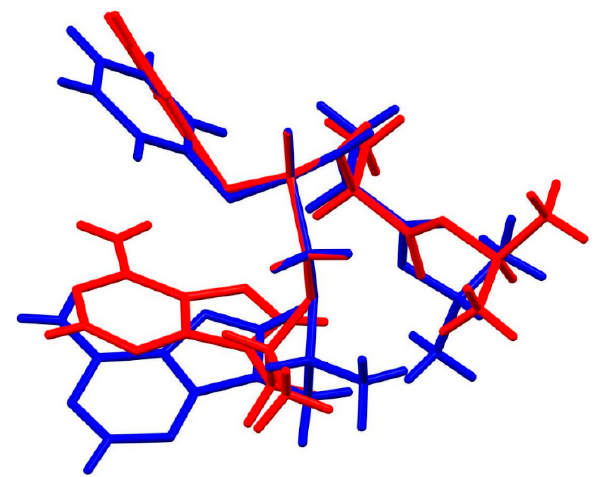
Figure 9. Superposition showing the difference in conformation of tenofovir alafenamide molecules in TA (red) and TA HF (blue). The disorder on the isopropyl and phenyl groups is omitted for clarity.